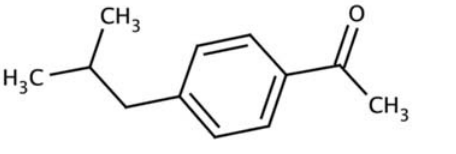
Figure 1b: Ibuprofen impurity (4-isobutylacetophenone)